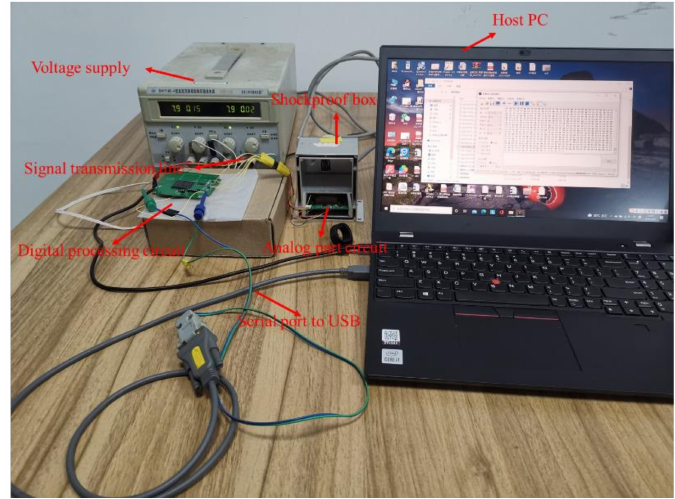
Figure 19. Photo of test environment of tri-axis